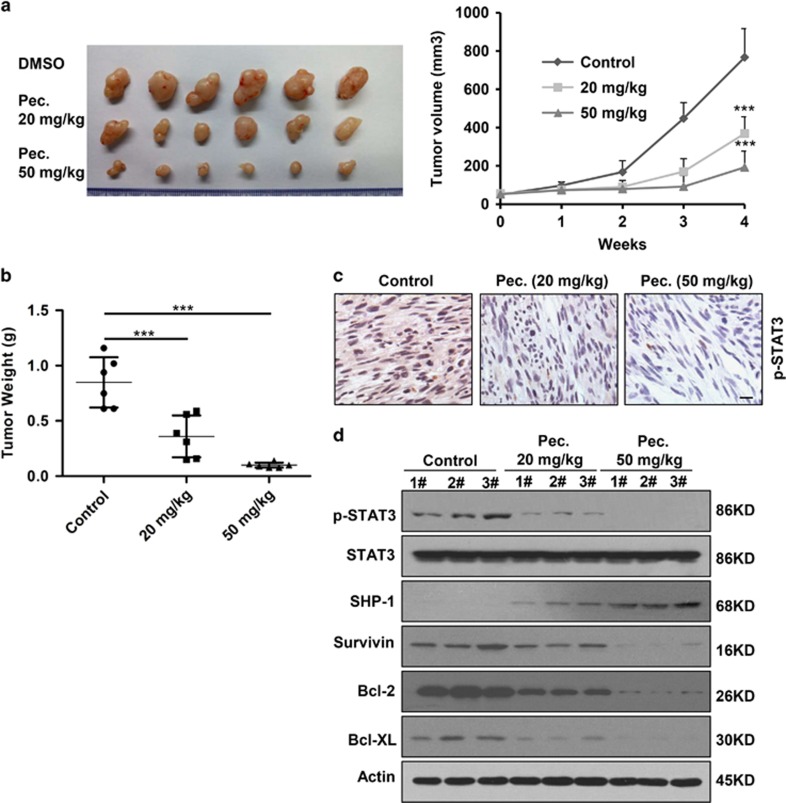
Pectolinarigenin inhibits tumor growth in a patient-derived osteosarcoma xenograft (PDX) animal model. (a) Representative images of patient-derived osteosarcoma grafts removed from mice after administration of pectolinarigenin for 28 days (left panel). Summary results of the PDX tumor volume in control group and pectolinarigenin-treated group (***P<0.001) (right panel). (b) PDX tumor weight in each group was measured (***P<0.001). (c) Patient-derived grafts were fixed and paraffin embedded. Four micrometer (4 μm) sections were analyzed by IHC using an anti-phospho-STAT3 (Y705) antibody. Scale bar, 100 μm. (d) PDX tumor was lysed and applied to immunoblotting with with indicated antibodies. Actin was used as a loading control